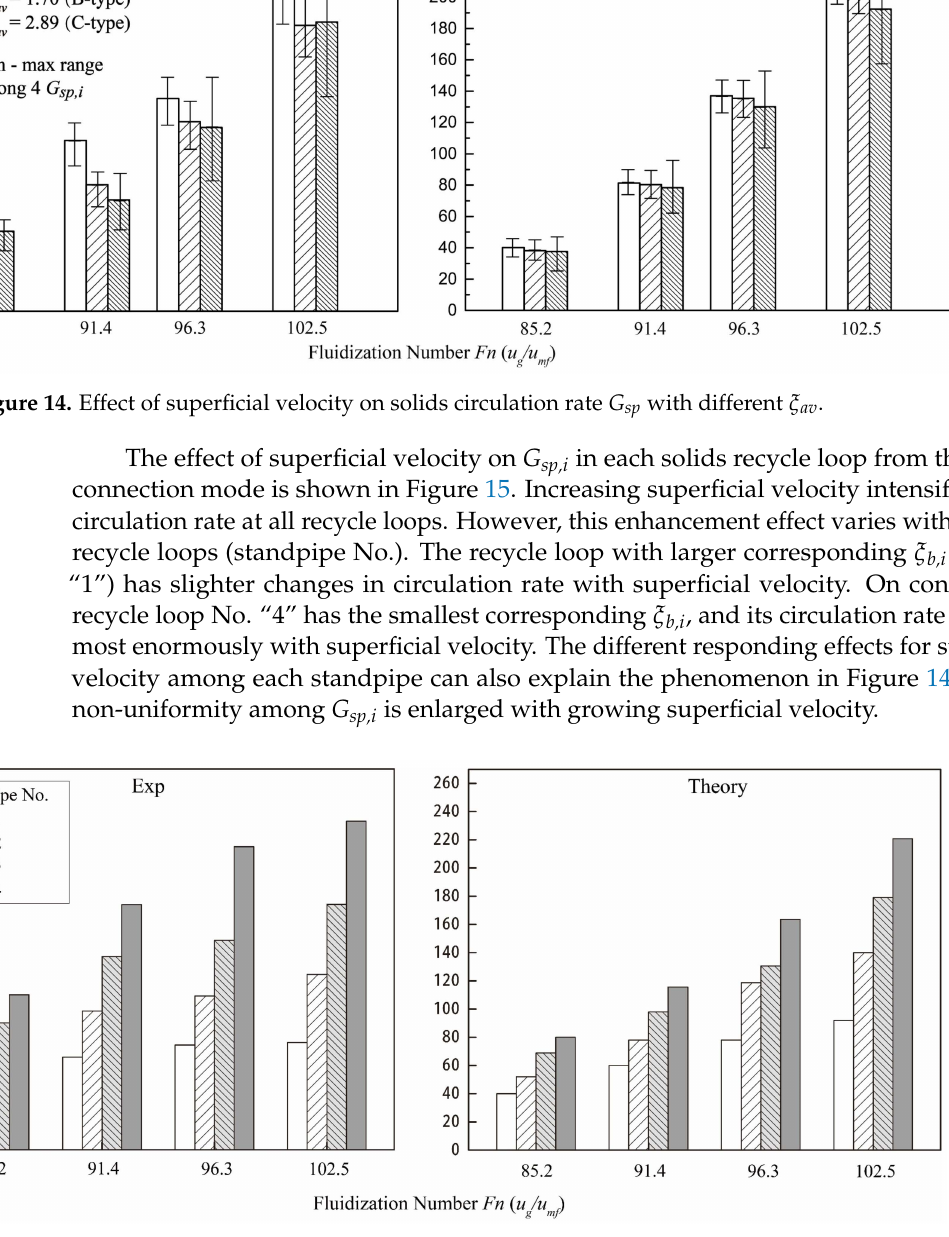
Figure 15. Effect of superficial velocity on G sp,i in each standpipe (C-type mode). Combined with Figures 12–15, it is apparent that the non-uniformity of furnace solids suspension distribution and solids circulation rate caused by connection resistance is en- hanced by superficial velocity. This can be further analyzed that, although ξ av of connection or ξ b,i among branches is constant, the connection pressure drop ( ∆ P EF,i in Equation (8) and variation among ∆ P EF,i in different branches are increased by growing velocity. As a result, the furnace gas-solid distribution profile and circulation rates allocation become more uneven with increasing superficial